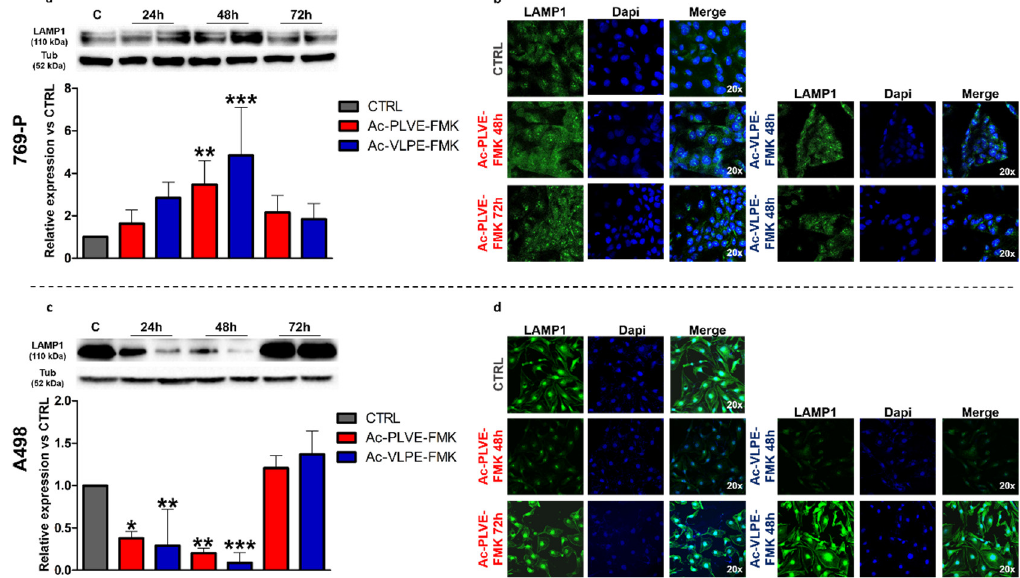
Figure 7. E ff ect of the peptides on LAMP-1 protein expression: ( a ) Western blotting analysis of LAMP-1 after treatment with PLVE and VLPE (20 µ M) for 24, 48, and 72 h in 769-P cells. ( b ) Confocal microscopy evaluation of LAMP-1 expression after 48 and 72 h of treatment with PLVE and VLPE (20 µ M) in 769-P cells. ( c ) Western blotting analysis of LAMP-1 after treatment with PLVE and VLPE (20 µ M) for 24, 48, and 72 h in A498 cells. ( d ) Confocal microscopy evaluation of LAMP-1 expression after 48 and 72 h of treatment with PLVE and VLPE (20 µ M) in A498 cells. Data are represented as mean ± SD of at least three replicates. Significance was calculated through one-way ANOVA followed by Dunnet’s test. * = p < 0.05, ** = p < 0.01, *** = p < 0.001.